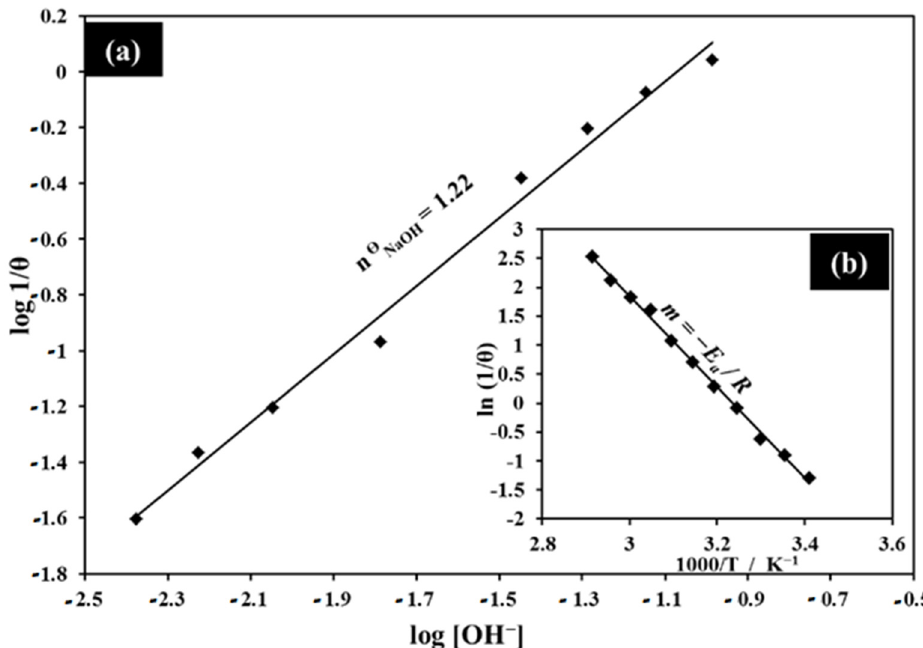
Figure 9. ( a ) Order of reaction of the ammonium-sodium jarosite with arsenic in NaOH media. 1/ θ = [OH − ] 1.22 . ( b ) Dependence of induction time ( θ ) on temperature, E a = 65.0 kJ/mol in NaOH media.